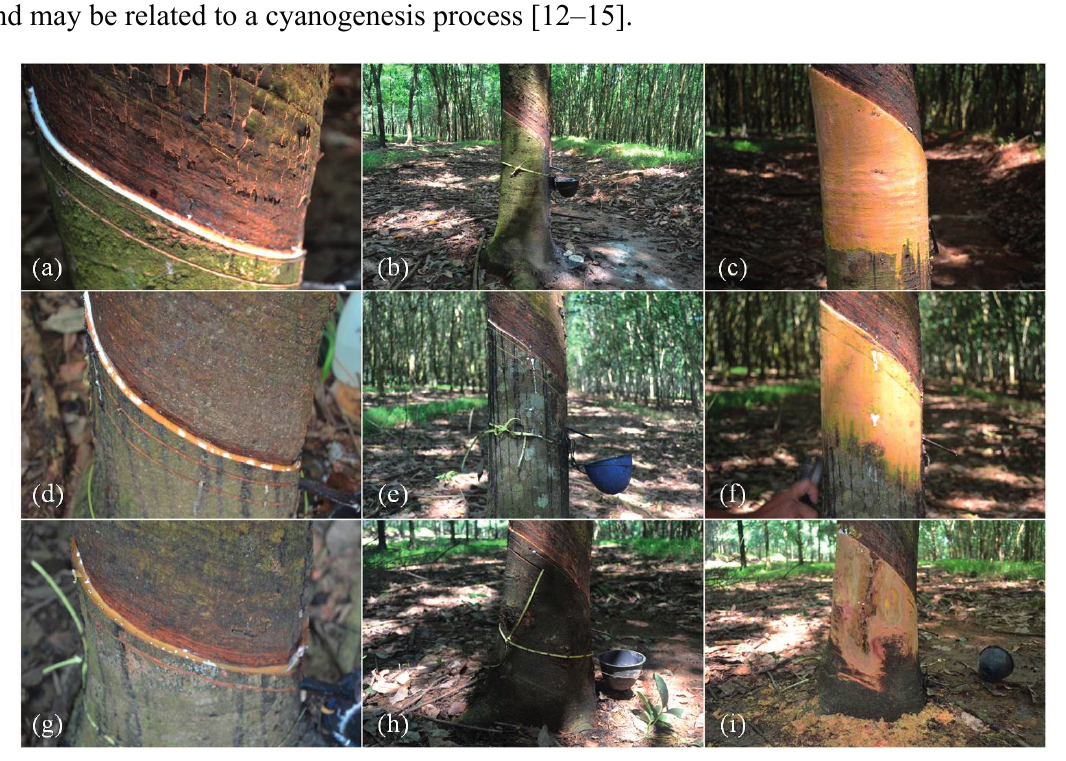
Figure 1. Illustration of Tapping Panel Dryness (TPD) symptoms in Hevea brasiliensis plantation. ( a ) Normal latex flow on tapping panel; ( b ) Healthy bark; ( c ) Healthy bark after scrapping; ( d ) Partial cessation of latex flow related to reactive oxygen species-Tapping Panel Dryness (ROS-TPD); ( e ) ROS-TPD bark; ( f ) ROS-TPD bark after scrapping; ( g ) Total cessation of latex flow related to brown bast-TPD (BB-TPD); ( h ) BB-TPD bark; ( i ) BB-TPD bark after